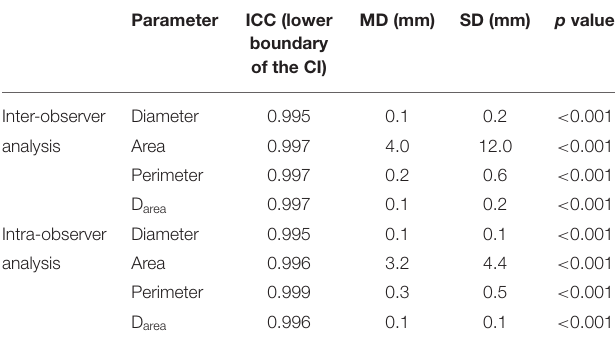
TABLE 4 | The intraclass correlation coefficient analysis